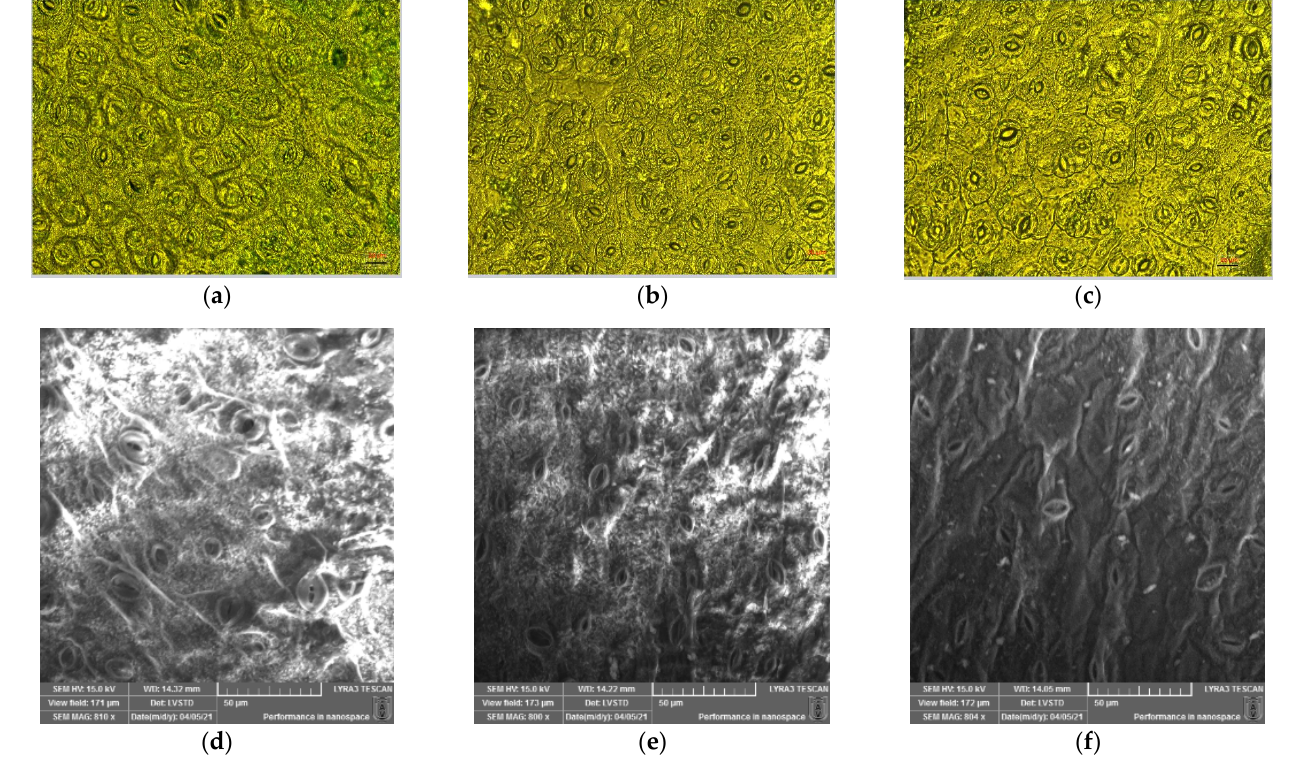
Figure 6. Microscopy images that present the stomatal pattern of leaf surfaces of Brassica oleracea italic recorded with an optical microscope (( a – c ), with the scale bar 20 µm) and SEM micrographs (( d – f ), magnification 800×) for leaf plants grown at 400 ( a , d ), 800 ( b , e ), and 1200 ( c , f ) ppmv CO 2 . The pore apertures of plants grown at lower concentrations of CO 2 remained larger than those of other plant groups. Stoma pore length slightly decreased from 14.65 ± 2.88 µm at 400 ppmv CO 2 to 13.57 ± 1.93 µm at 800 ppmv CO 2 , but only became statistically different at 1200 ppmv CO 2 (8.01 ± 0.88 µm, one way ANOVA followed by Tukey’s mul- tiple comparisons post hoc test, p < 0.05).